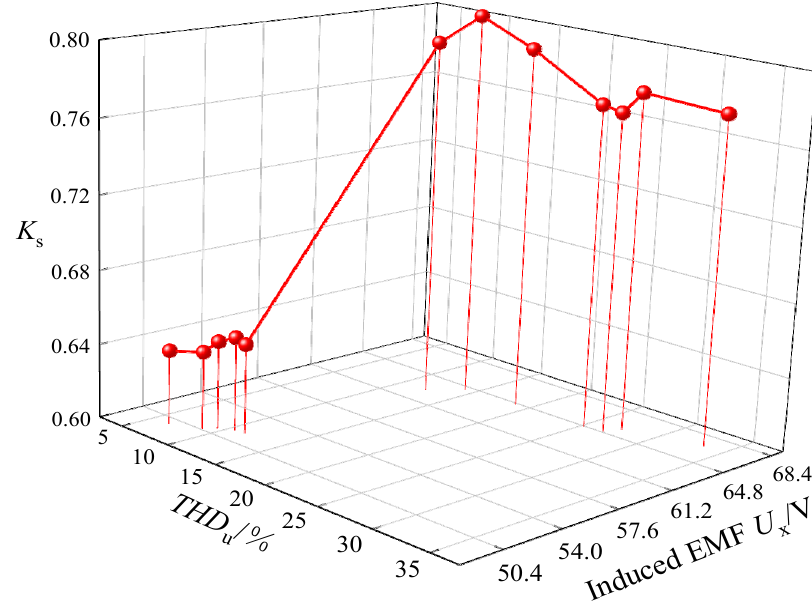
Figure 14. Relationship between two optimization goals and matching coefficients.